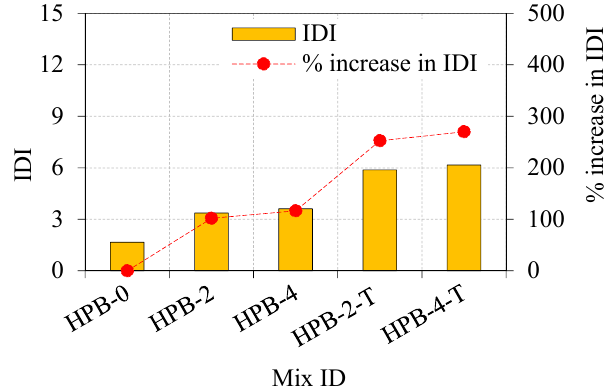
Figure 13. Impact ductility index.